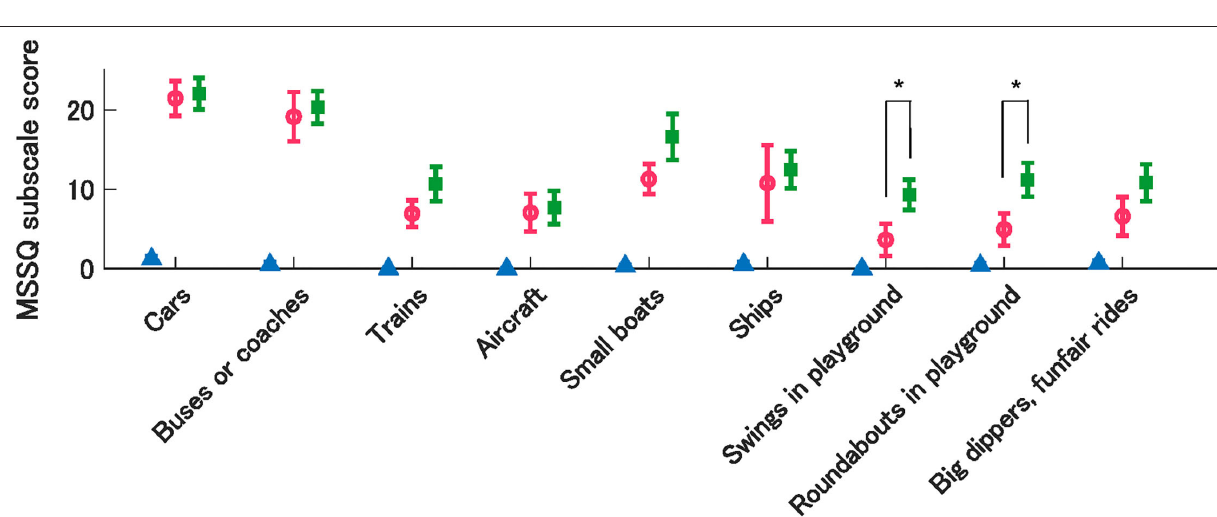
modalities but also within the vestibular sense is capable